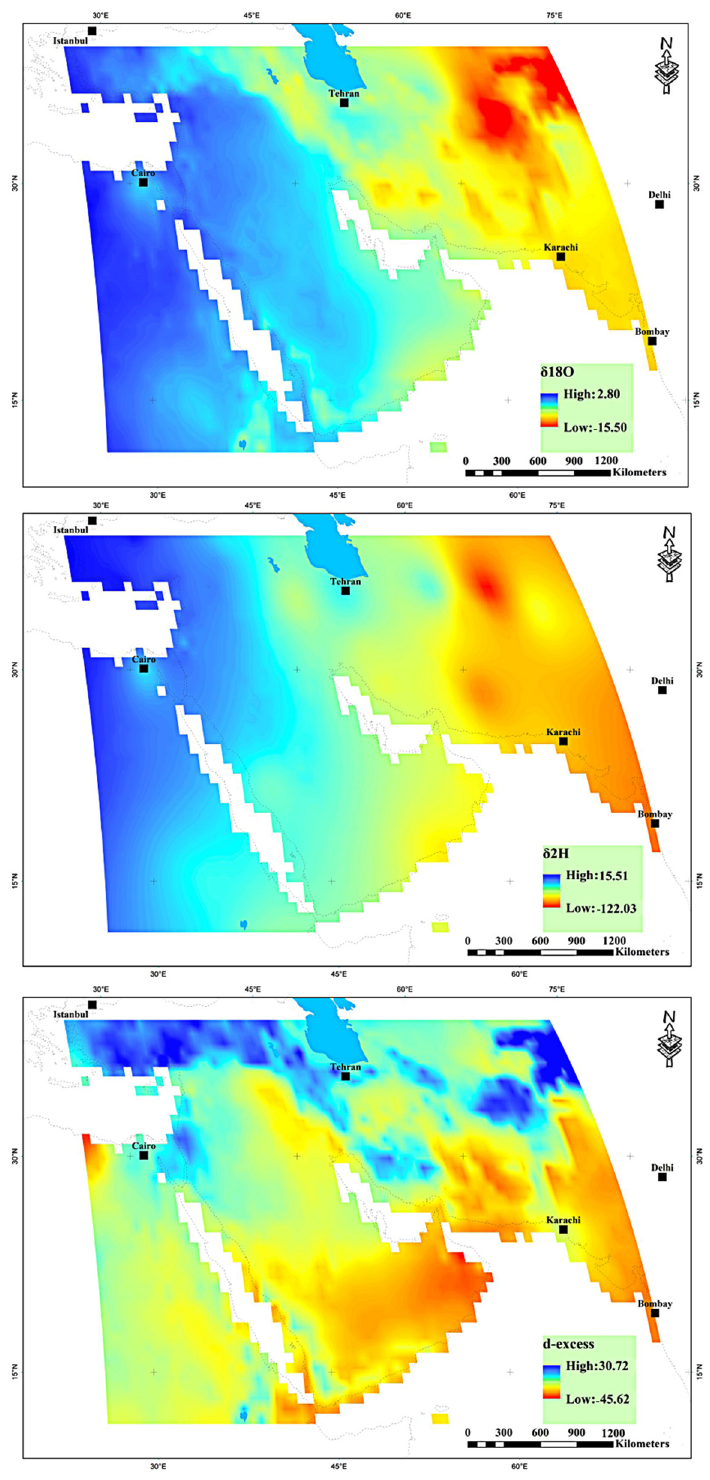
Figure 4. The error maps of the δ 18 O, δ 2 H, and d-excess values (the differences between the real and simulated isotopic values) in precipitation across the Middle